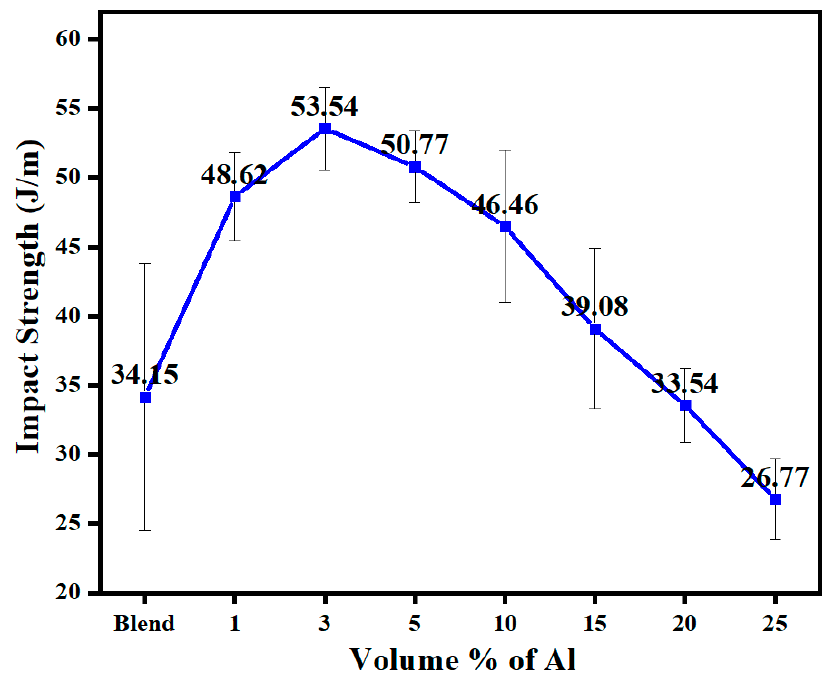
Figure 12. The impact resistance of 60/40 PBT/PET filled with aluminium nano